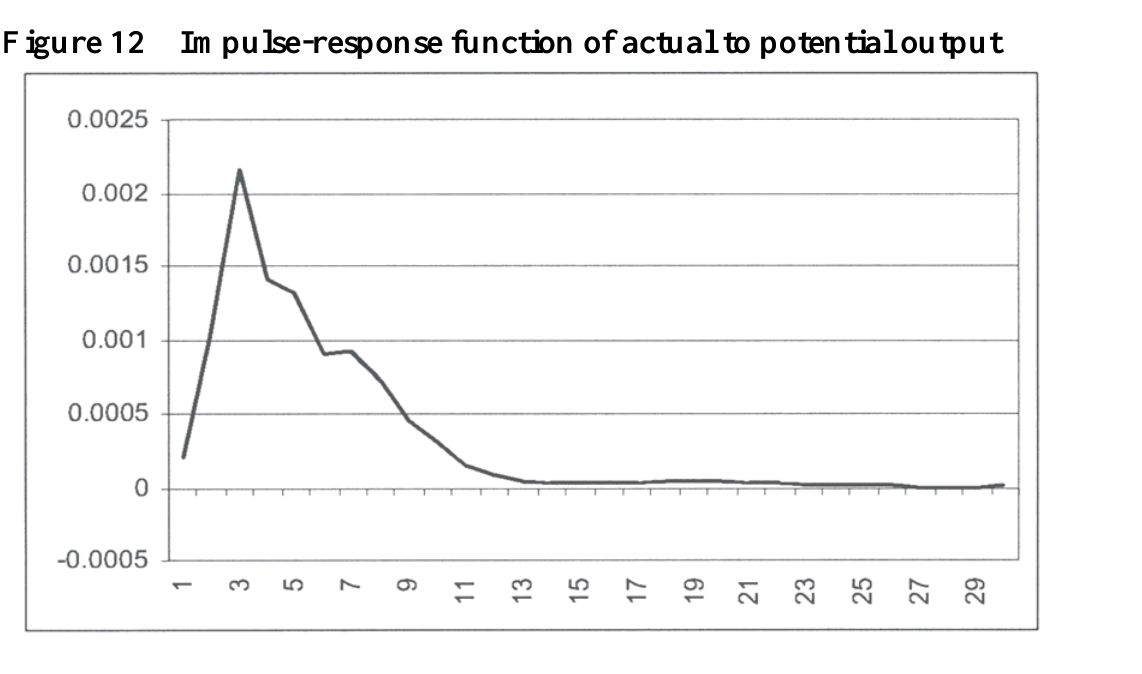
Figure 12 Impulse-response function of actual to potential